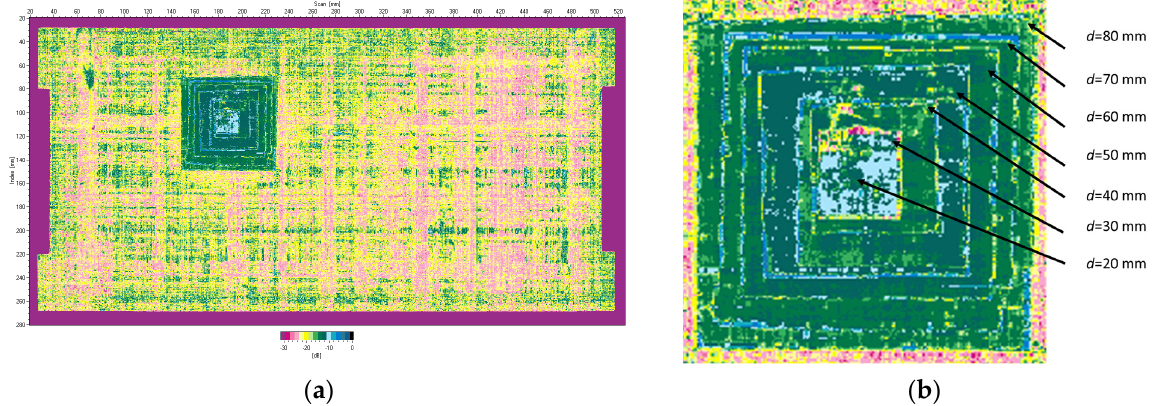
Figure 5. Ultrasonic C-scan (time-of-flight mode) of the plate with artificial damage scanned from the bottom side: ( a ) full scan; ( b ) zoom-in on the delamination.